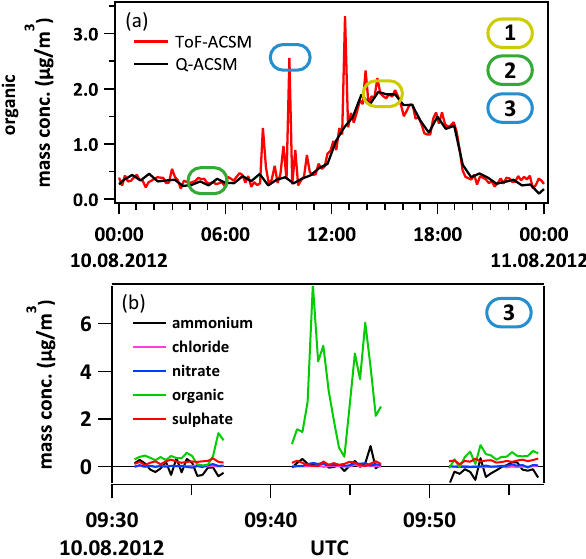
Fig. 5. (a) Organic mass concentrations measured on 10 Au- gust 2012 with the ToF-ACSM (red line, time resolution: 10min) and the Q-ACSM (black line, time resolution: 30min). The aver- age spectra recorded in the regions marked in yellow (14:00–16:00, case 1, higher concentrations), green (04:00–06:00, case 2, lower concentrations) and blue (10:00, case 3, short-term peak only seen by ToF-ACSM) are discussed in Fig. 6. (b) Time series during pe- riod 3 with the highest available time resolution of 20s. The gaps in the data indicate periods the instrument was acquiring the back- ground